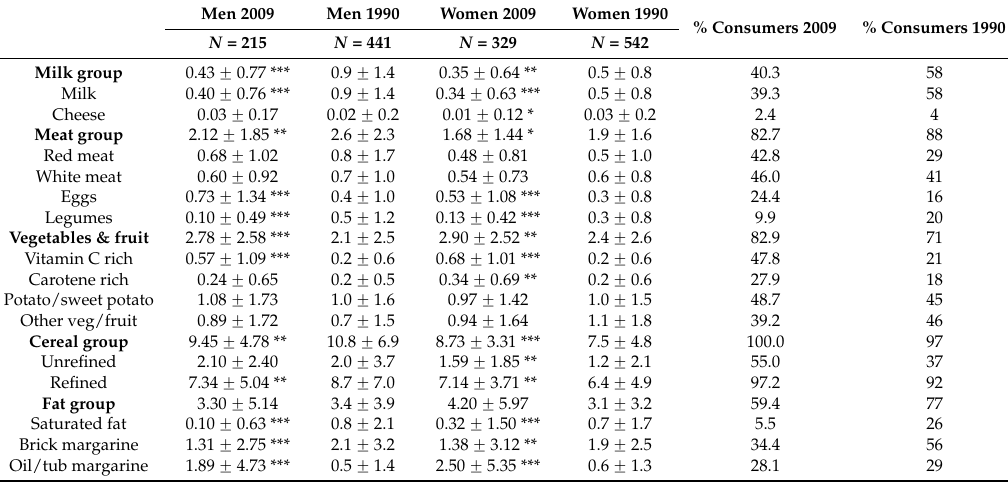
Table 4. Portion sizes 1 consumed by the study participants in 1990 [9] and in 2009.